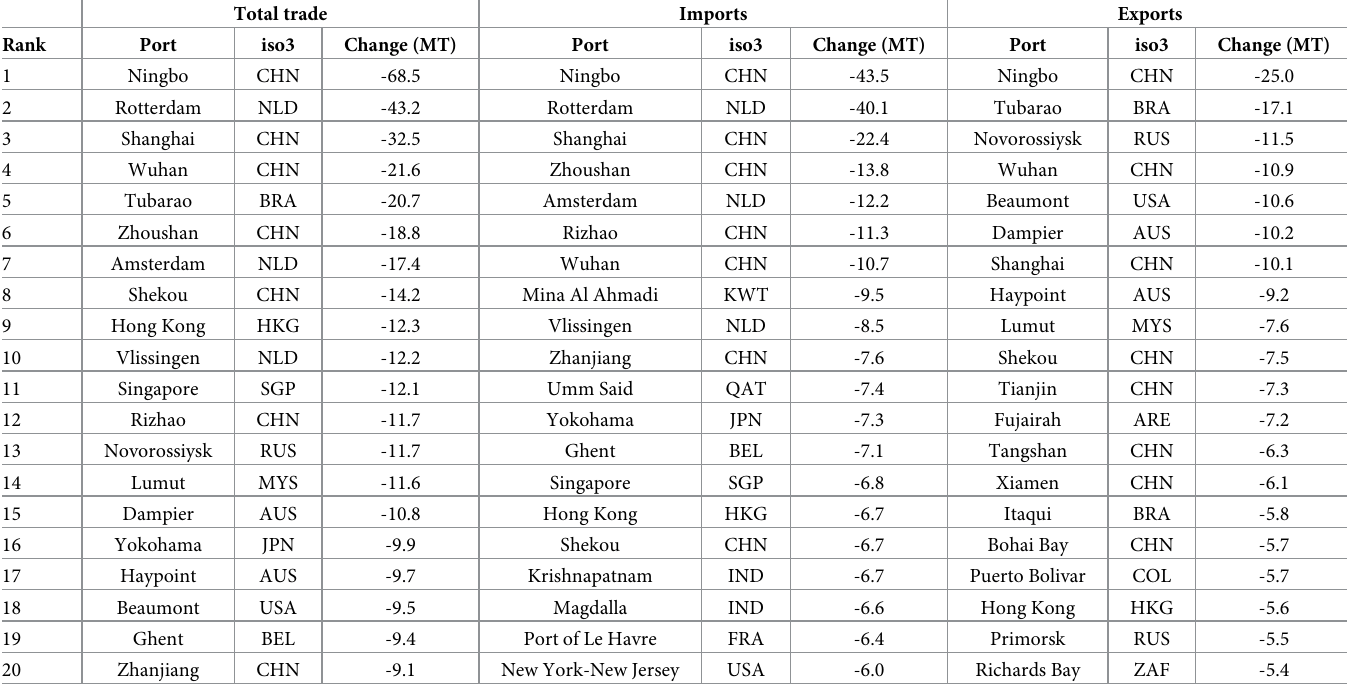
Table 1. Largest absolute trade losses on a